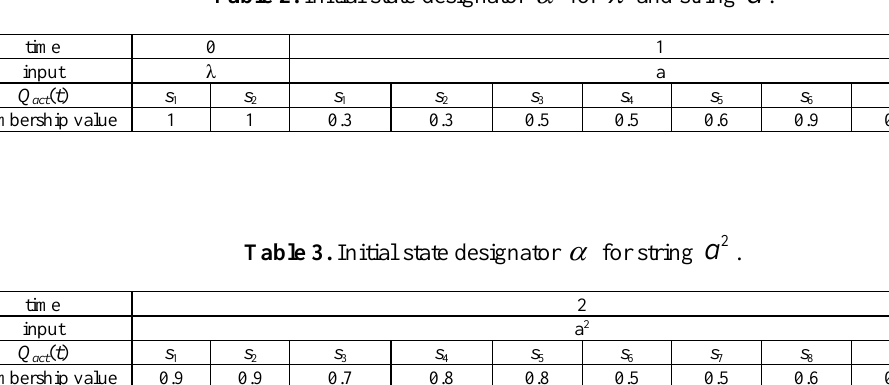
Table 2. Initial state designator  for  and string a .